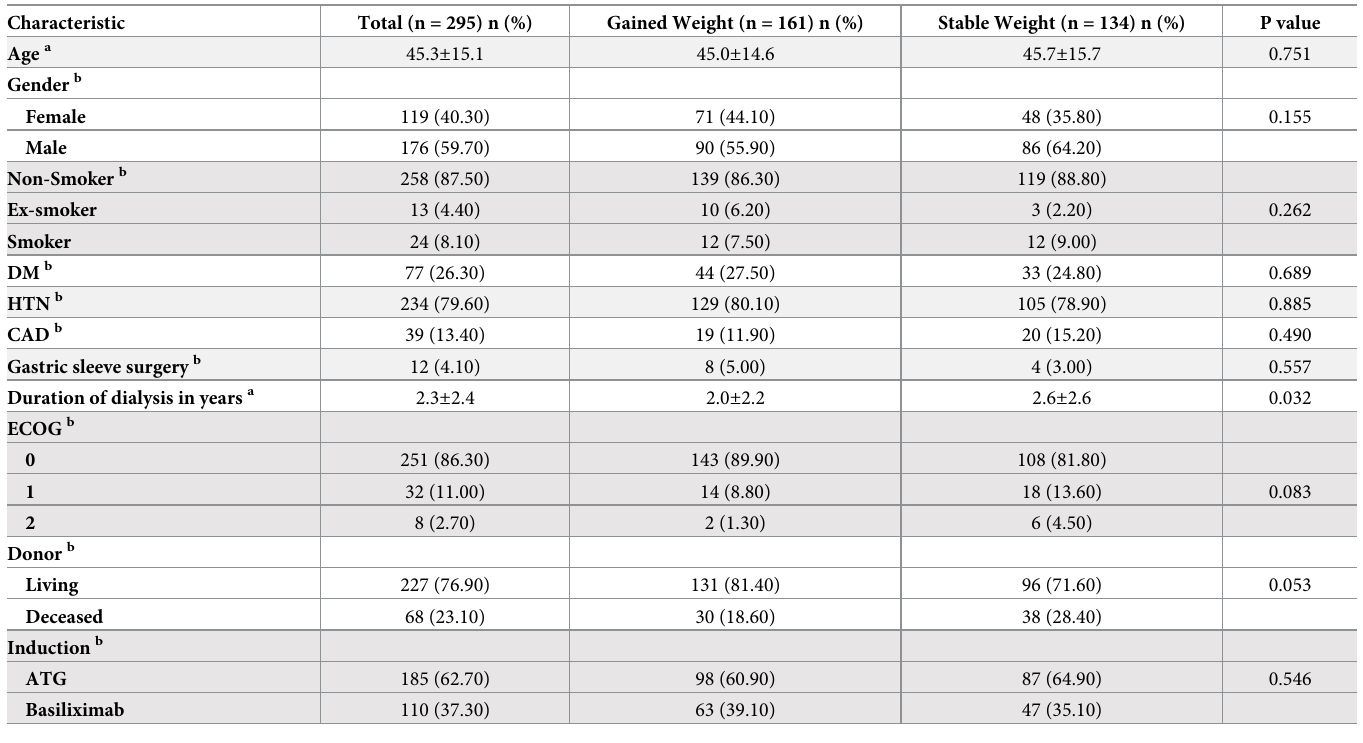
Table 1. Baseline